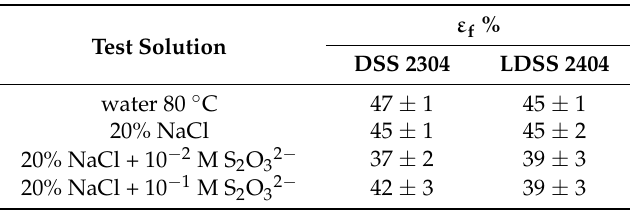
Table 2. Average values and standard deviations of ε f % for DSS 2304 and LDSS 2404 obtained from SSRT at 80 ◦ C in water and in 20% NaCl solution, in the absence and in the presence of 10 − 2 and 10 − 1 M S 2 O 32 −